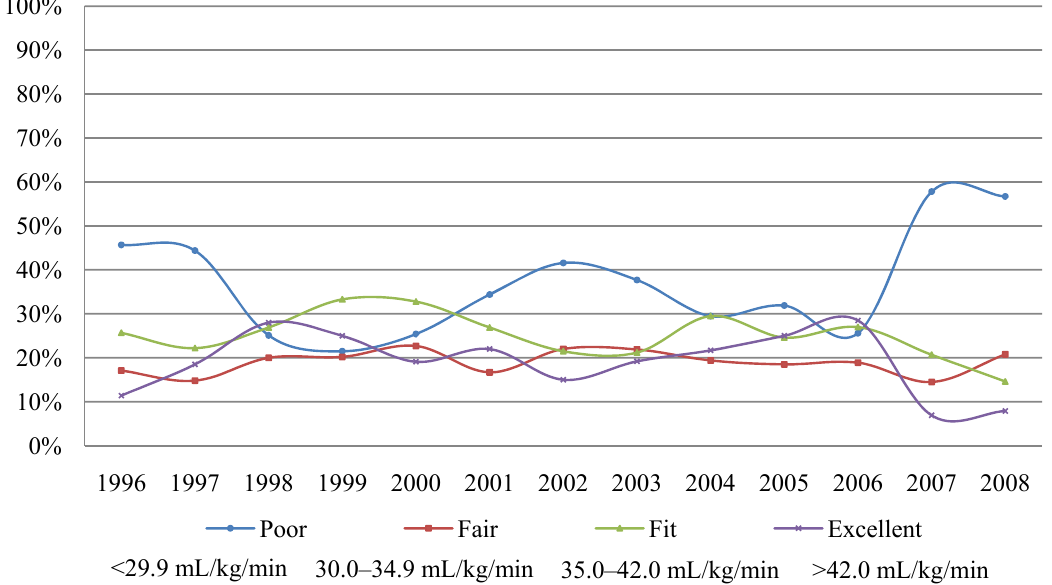
Figure 4. Percentage of females falling into the four difference fitness categories